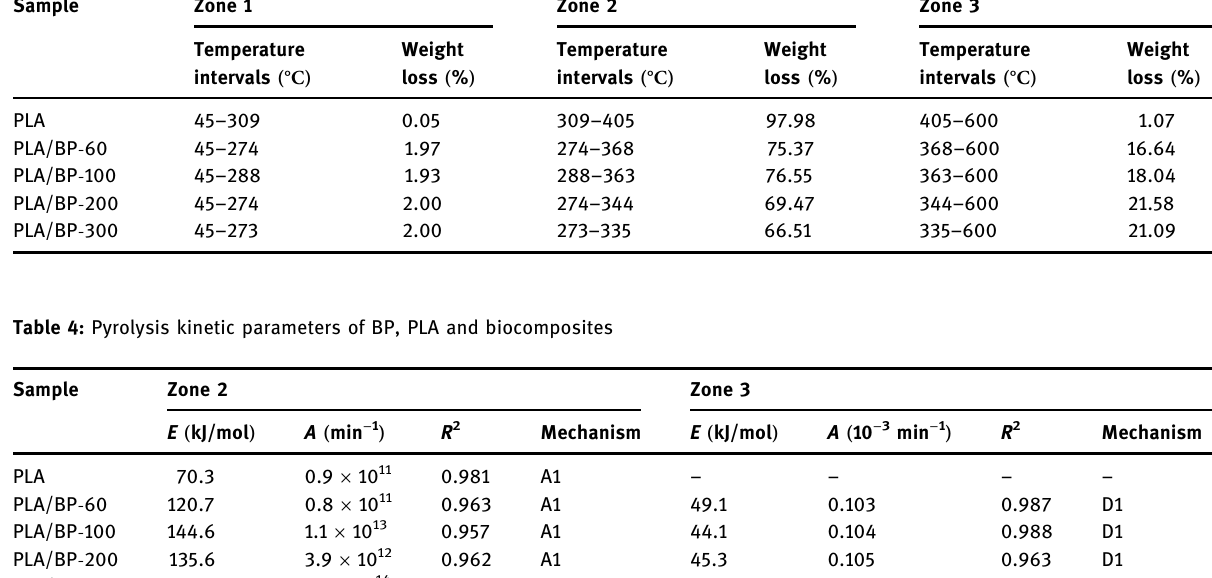
Table 3: Weight loss at di ff erent temperature intervals during combustion of samples